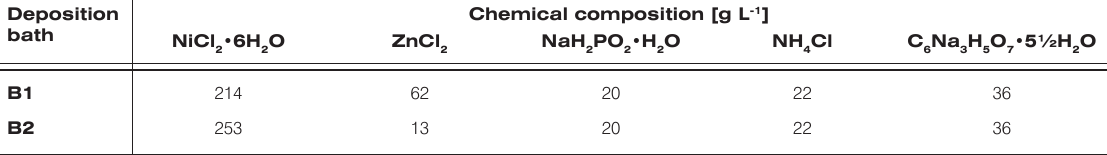
Chemical composition [g L -1 ]